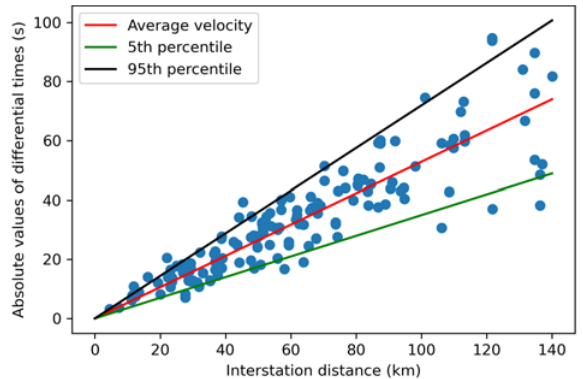
Table 1: Propagation velocities as minimum, average and maximum velocities for each frequency band. Min- imum is for the 95 th percentile and maximum is for the 5 th percentile of the data.